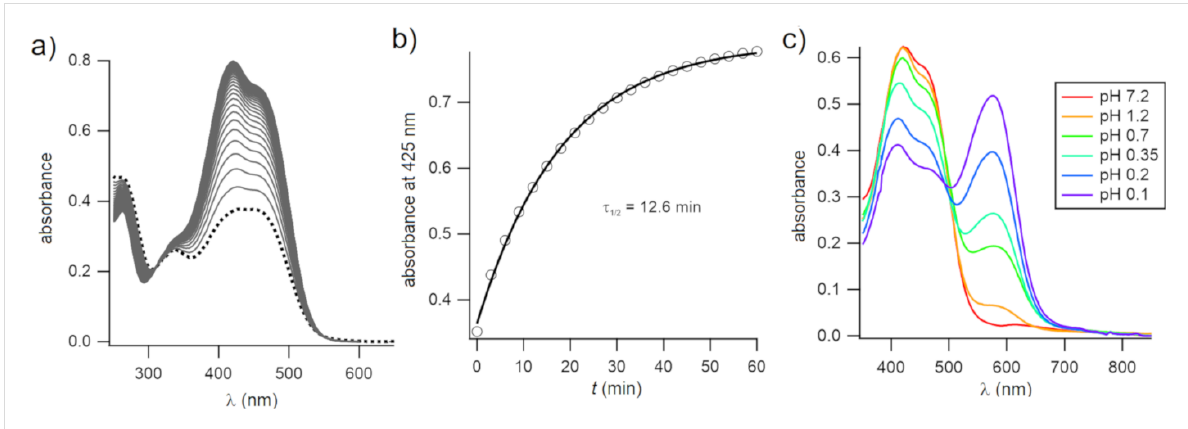
Figure 4: a) UV–vis spectra of 5 in aqueous solution ( c ≈ 15 µM, 5% methanol, pH 7) at the PSS and 440 nm irradiation (thick dotted line; ca. 60% Z -isomer) and during thermal reversion to the dark-adapted state (solid black line). b) Time course of thermal reversion at 22 °C. Data were fitted to a single exponential decay equation (solid line). c) Spectra of an aqueous solution of 5 upon addition of hydrochloric acid, as indicated by pH values. The wavelength of the absorption maximum of the azonium ion was 575